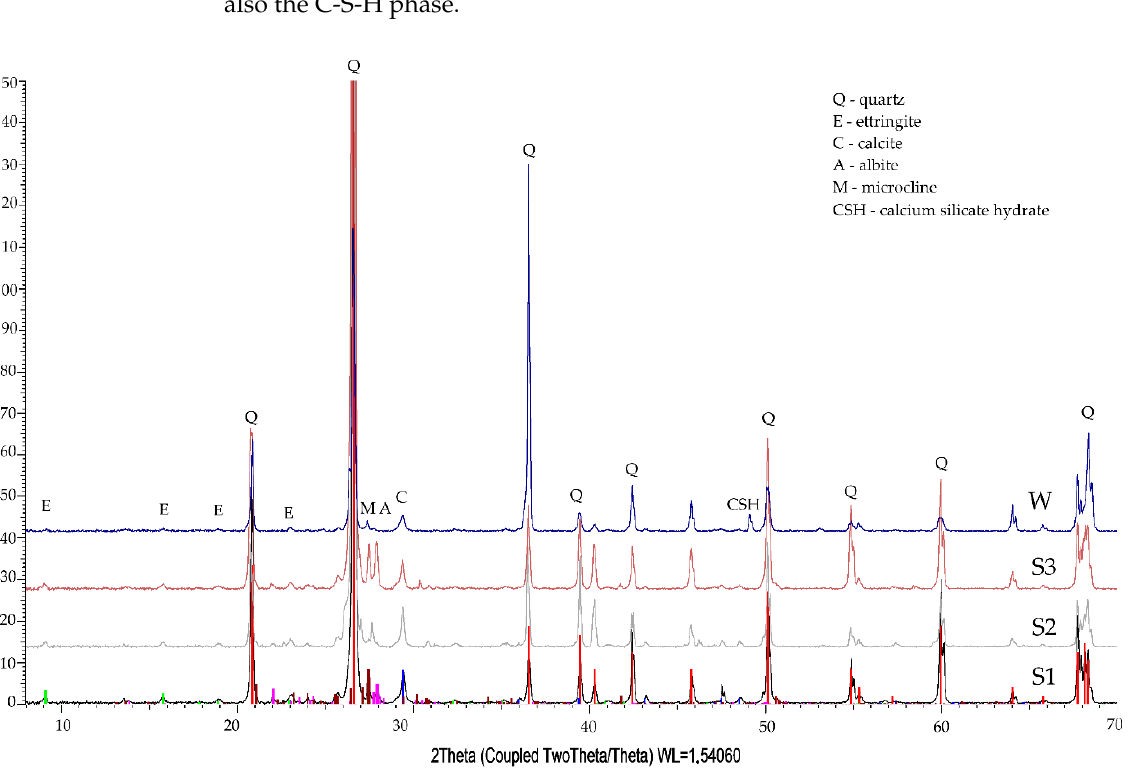
Figure 6. Diffraction pattern of specimen slices No. 1, 2, 3 (S1, S2, S3) after sulphate ion diffusion, against the background of the specimen stored in tap water (W).